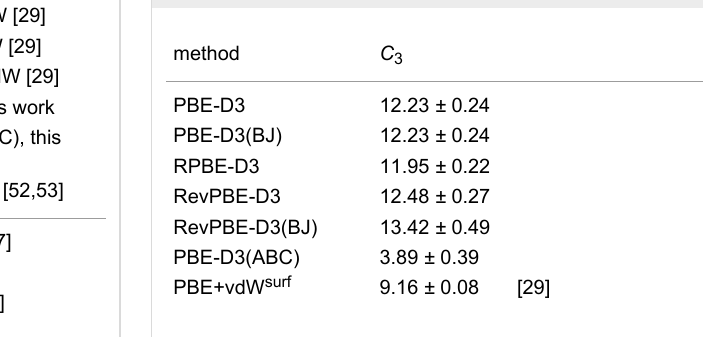
Table 4: C 3 coefficients in eV·Å 3 for benzene on the Au(111)